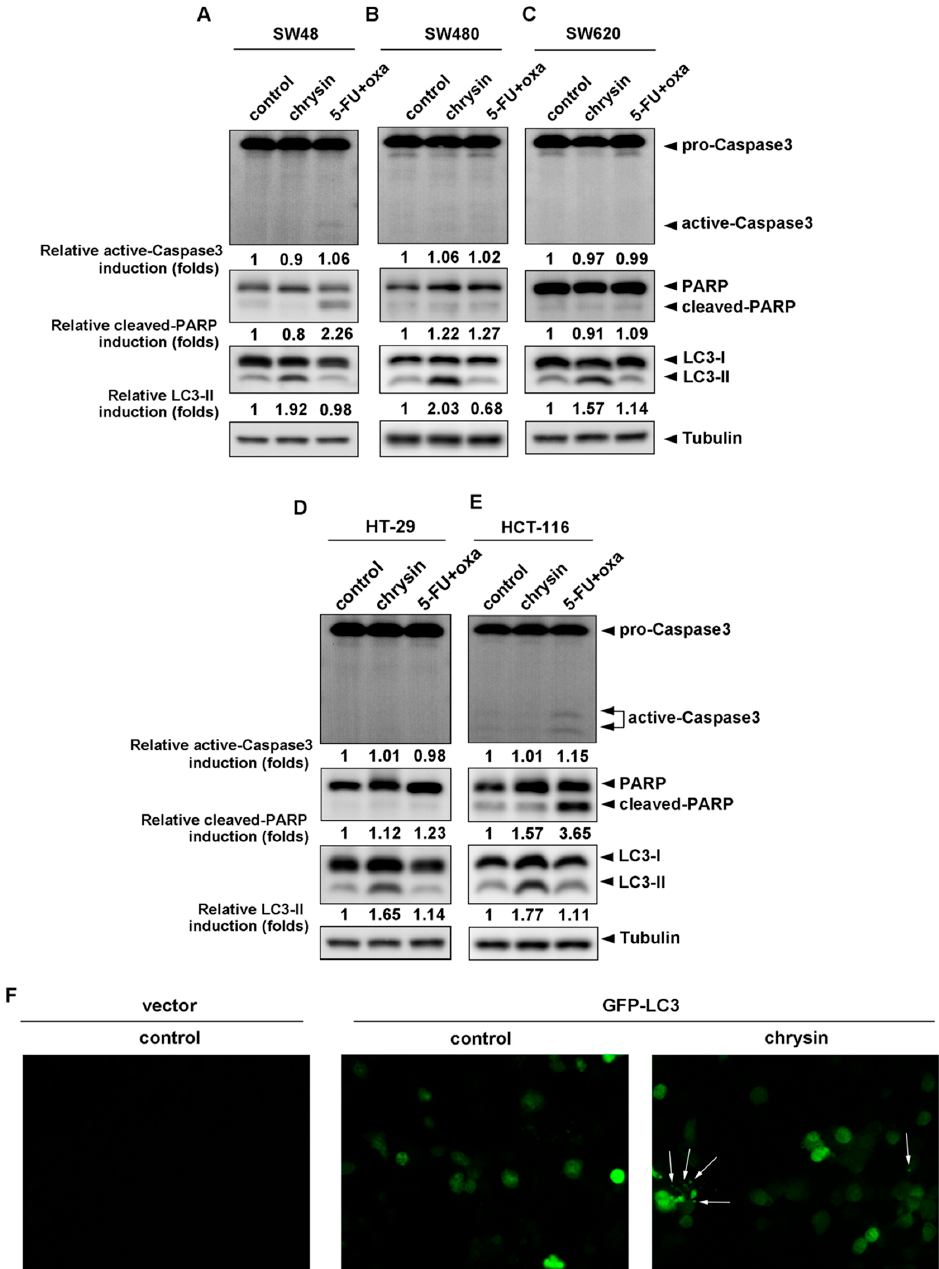
Figure 2. LC3-II levels were induced in chrysin-treated, but not 5-fluorouracil (5-FU)/oxaliplatin-treated colorectal cancer (CRC) cells. ( A – E ) Each CRC cell line was treated with the indicated concentrations of 50 μ M chrysin or 25 μ M 5-FU/25 μ M oxaliplatin for 24 h. Then, cells were harvested for western blot analysis. The expressions of cleaved forms of caspase-3 and poly-ADP-ribose polymerase (PARP), as well as of LC3-II, were examined using indicated antibodies. The band images were quantified using tubulin as a calibrated control. Relative fold inductions of activated caspase-3, cleaved PARP, and LC3-II were indicated as compared to control groups. ( F ) The GFP-LC3 expression vector was transfected into HCT-116 cells, followed by treatment with 50 μ M chrysin for 24 h. GFP-LC3 punctate structures were observed under a fluorescence microscope. White arrow represents GFP-LC3 punctate structure. The fluorescent images were displayed in a 10× multiplication.